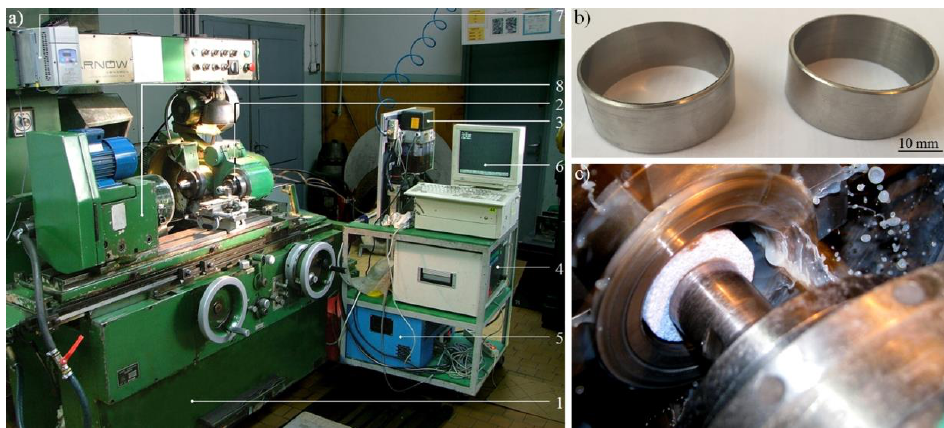
Figure 3. Experimental studies—set-up and workpiece: ( a ) general view of the experimental set-up used for realizing the internal cylindrical grinding process; ( b ) general view of the rings made of INCONEL ® alloy 718; ( c ) grinding wheel 1-35 × 10 × 10 × 109A5X60L10VE01PI-50 during machining of